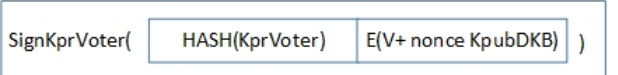
Figure 5. Signature of hash and encrypted vote + nonce.